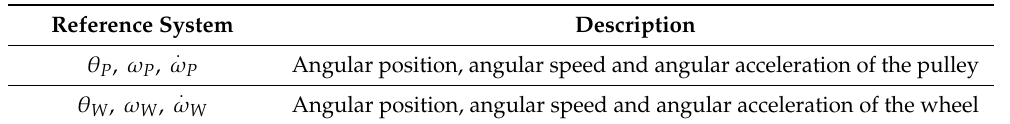
Table 2. Reference Table 2. Reference systems.